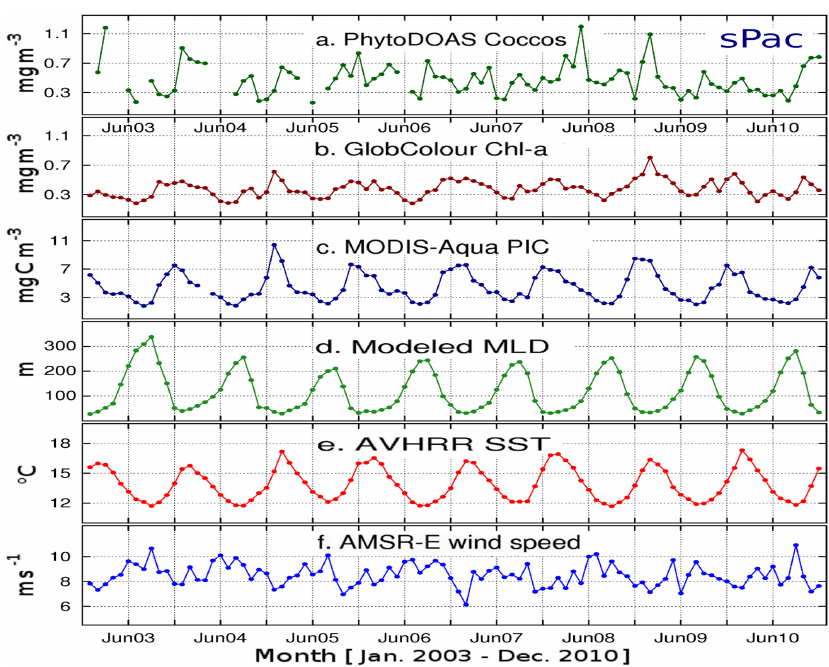
Fig. 5. Time series as described in Fig. 3, but for the sPac region.